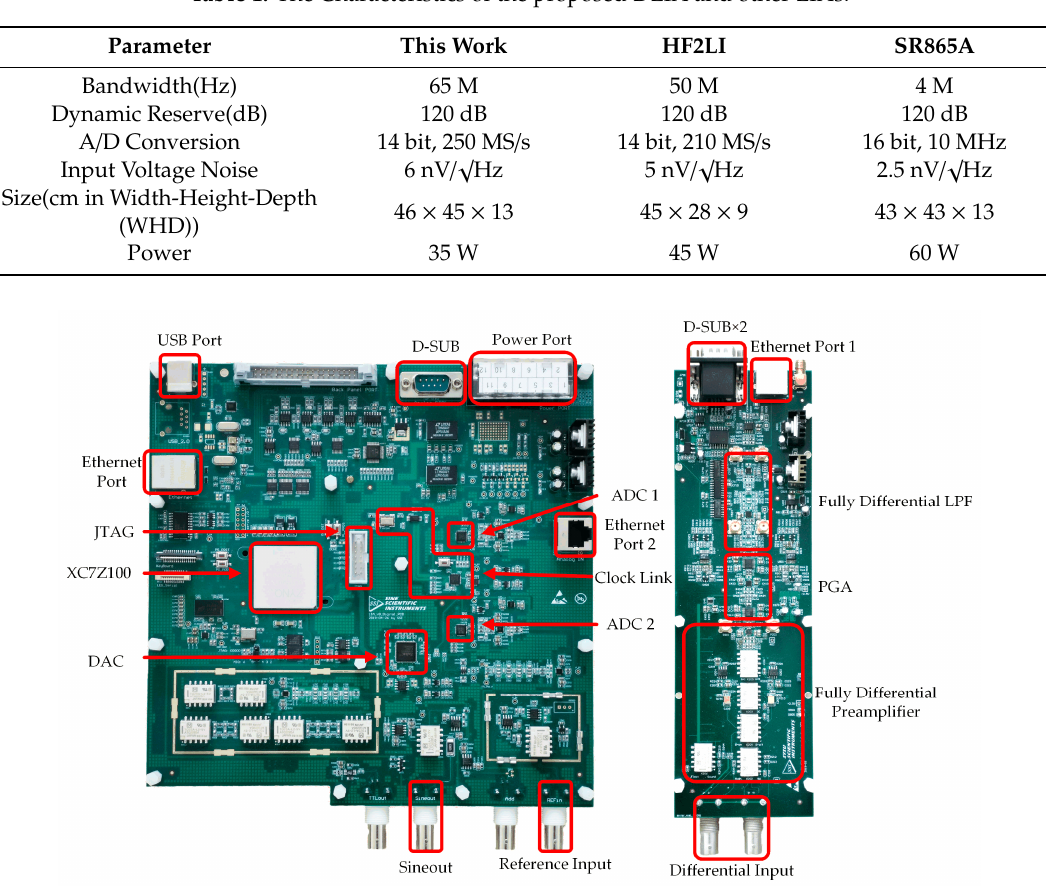
Figure 10. Photograph of the realized DLIA.